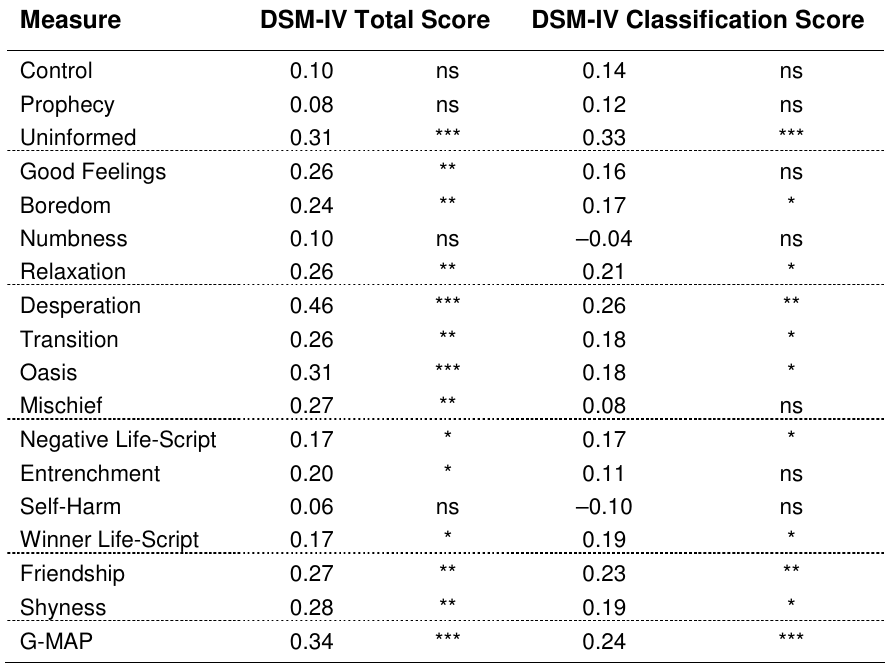
Correlation Coefficients on the Relationships Between the Chinese G-MAP Measures and the DSM-IV Measures